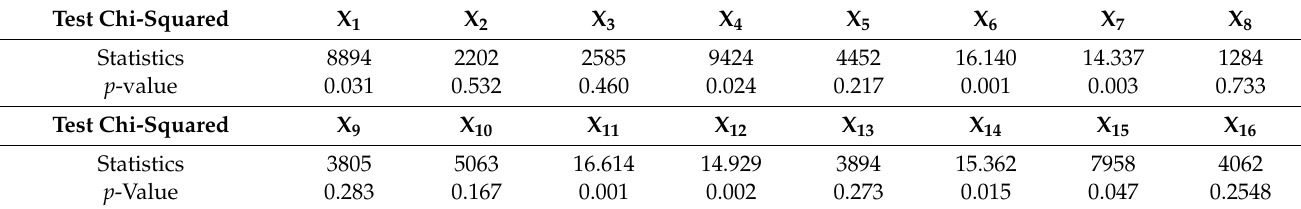
Table 13. Kruskal–Wallis test results—holistic